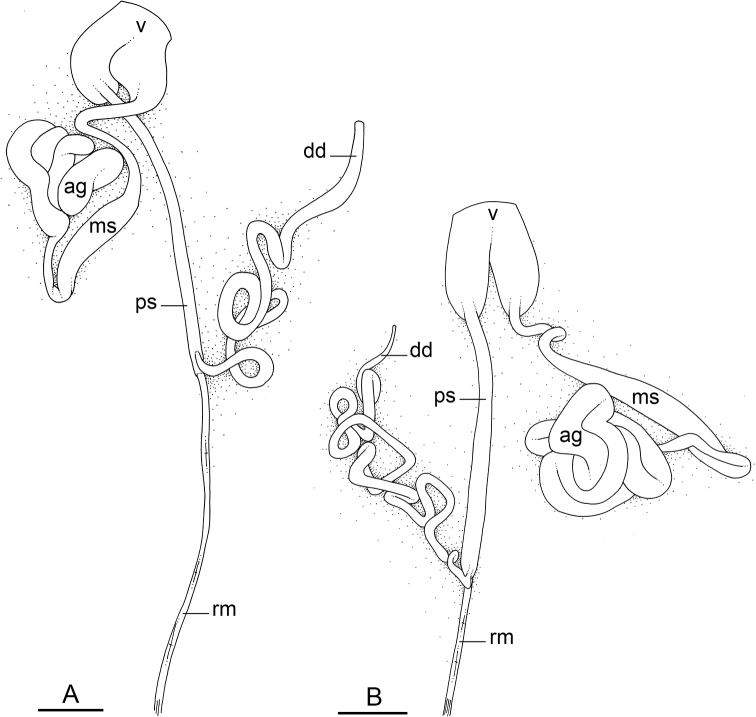
Anterior, male, copulatory apparatus, Peronia
griffithsiA holotype, Mauritius [3157 H] (MNHN-IM-2000-35265) B Indonesia, Kei Islands [2936] (UMIZ 00176). Scale bars: 1 mm (A, B). Abbreviations: ag accessory penial gland, dd deferent duct, ms muscular sac, ps penial sheath, rm retractor muscle, v vestibule.